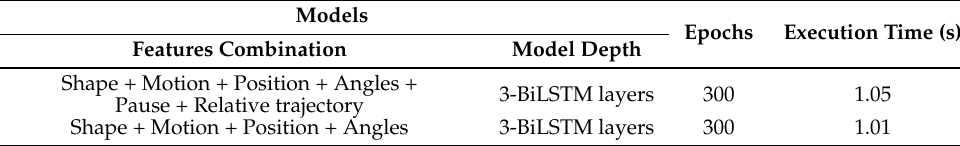
Table 7. Proposed models